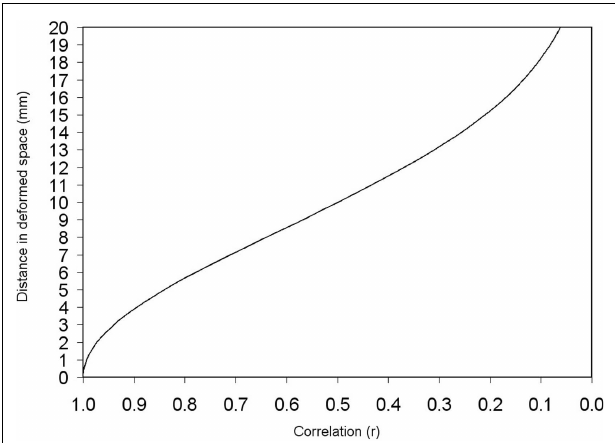
FIGURE 4 | Deformed distance between two adjacent voxels depending on the correlation between them . Deformed distances in this example have been calculated for σ = 8.5mm (FWHM = 20mm). Note, however, that the recreation of effect size map does not indeed depend on FWHM when full anisotropy is used [see text, Eq. 2 and Figure 6